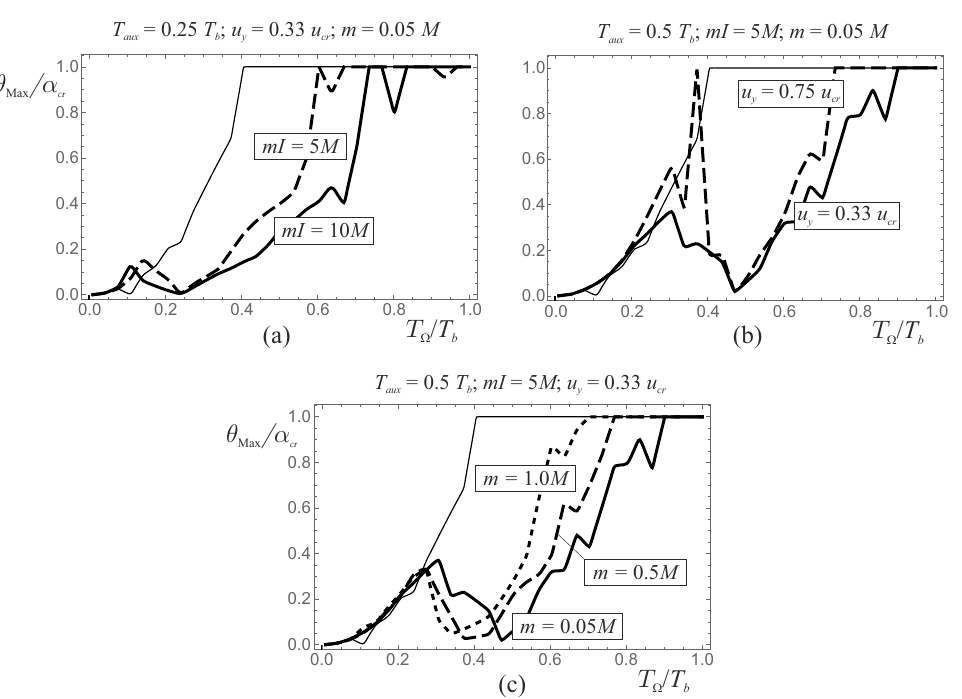
Figure 6b refer to a rigid block with dimensions 2 b = 1.2 m and λ = 6. Each graph includes the frequency–response curves of two coupled systems (thick solid and dashed line) obtained for different apparent mass m I and of the stand-alone rigid block (thin line). Although the dimensions of the rigid block are different from those of the previous analyses, the results lead to the same conclusions, suggesting that the behaviour of the coupled system is more sensitive to the value of m I / M than to the geometric characteristics of the rigid block. T = 0.25 T ; u = 0.33 u ; m = 0.05 M aux